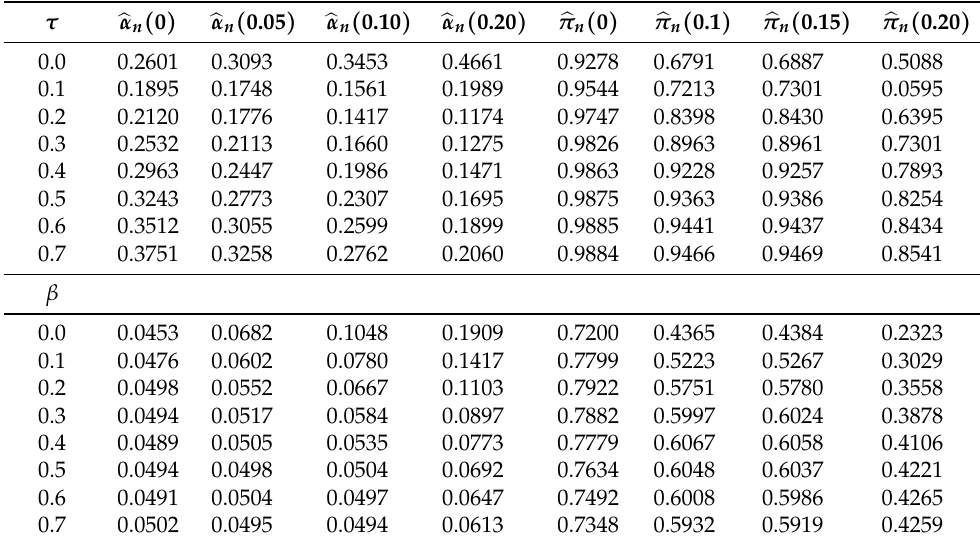
Table 1. Simulated levels for different contamination proportions and different tuning parameters